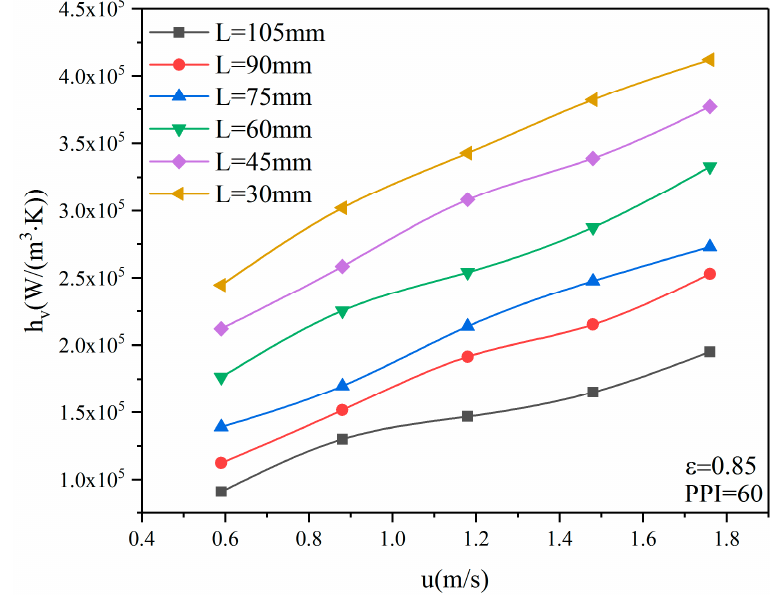
Figure 3. Curve of the experimental volumetric heat transfer coefficients change with velocity.